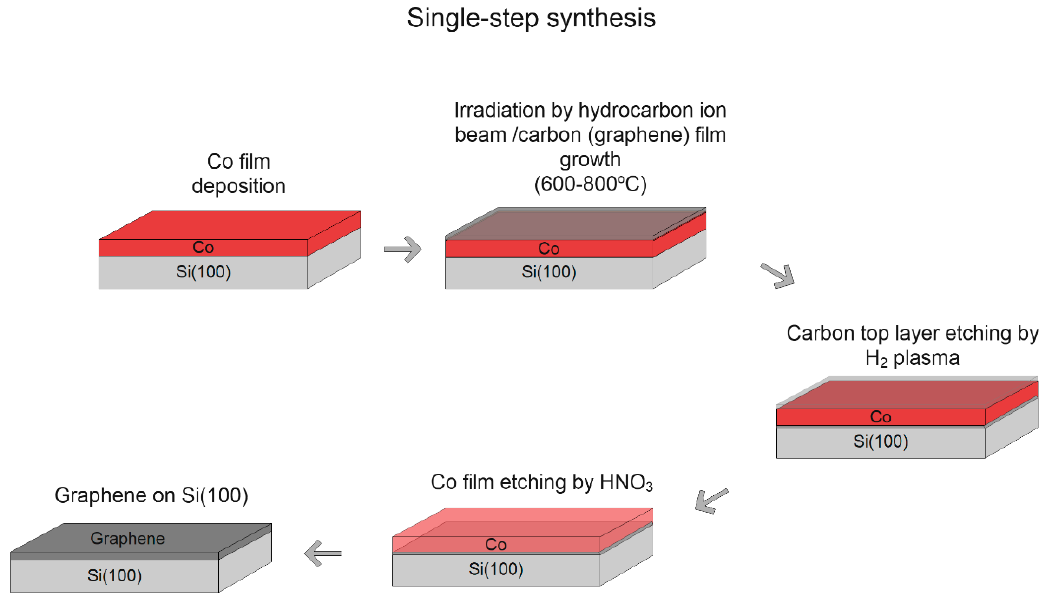
Figure 1. The diagram of a direct cobalt ‐ assisted single ‐ step ion beam synthesis.